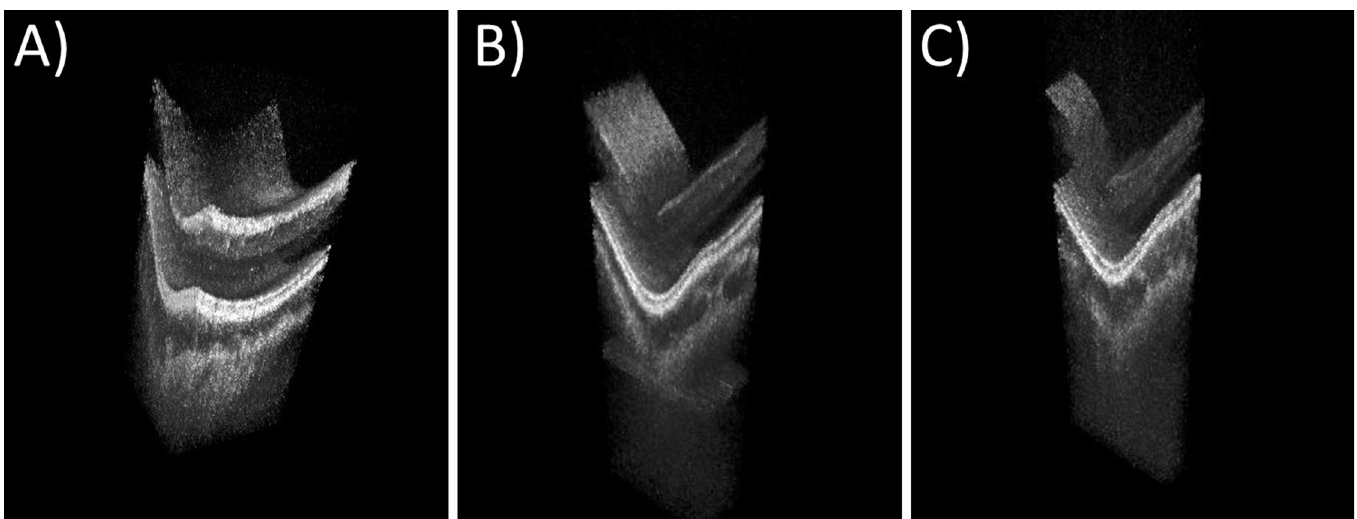
Fig 5. Videos from non-live imaging in real time playback and slow-motion playback with 20 Hz volume rate. A) 160x160 A-scans at 52 Hz with 4.5x4.5x4.2 mm in size(S1 and S2 Videos) B) 160x80 A-scans at 102 Hz with 4.5x2.1x4.2 mm in size (S3 and S4 Videos) and C) 160x40 A-scans at 191 Hz volume rate with 4.5x0.9x4.2 mmin size(S5–S6